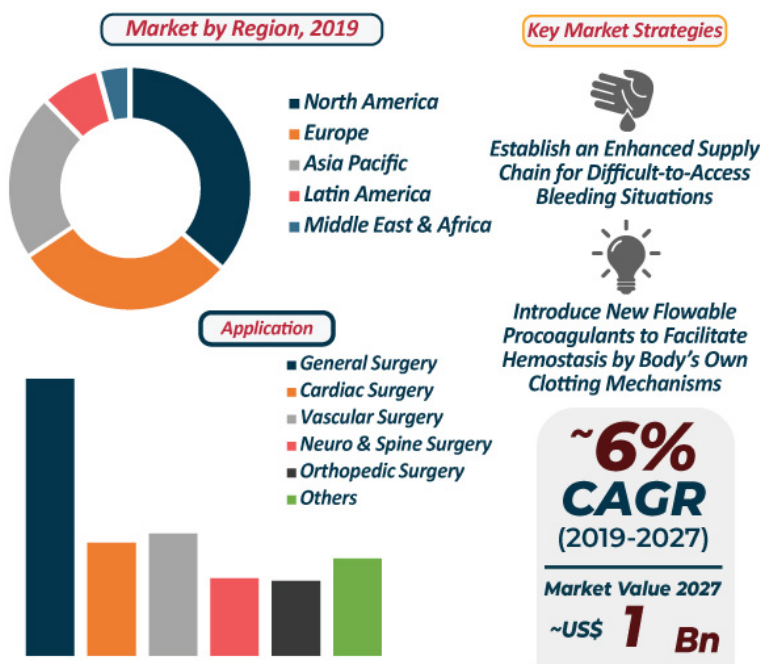
Figure 5. Flowable Hemostats market: 2019–2027 [165] .